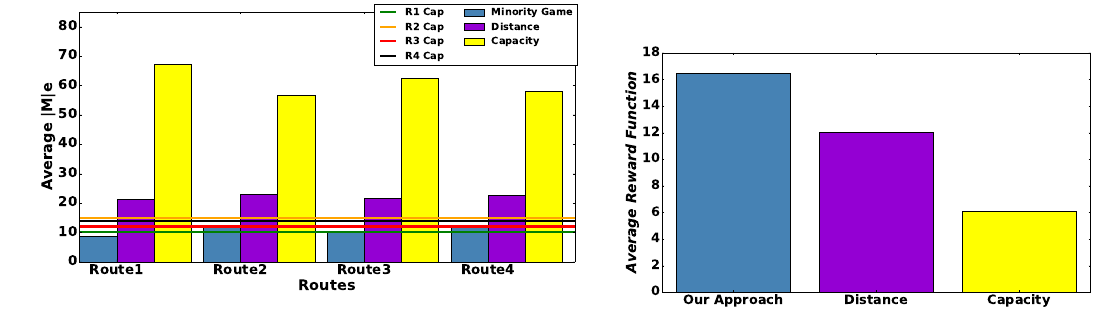
Figure 5. Comparative analysis—Scenario